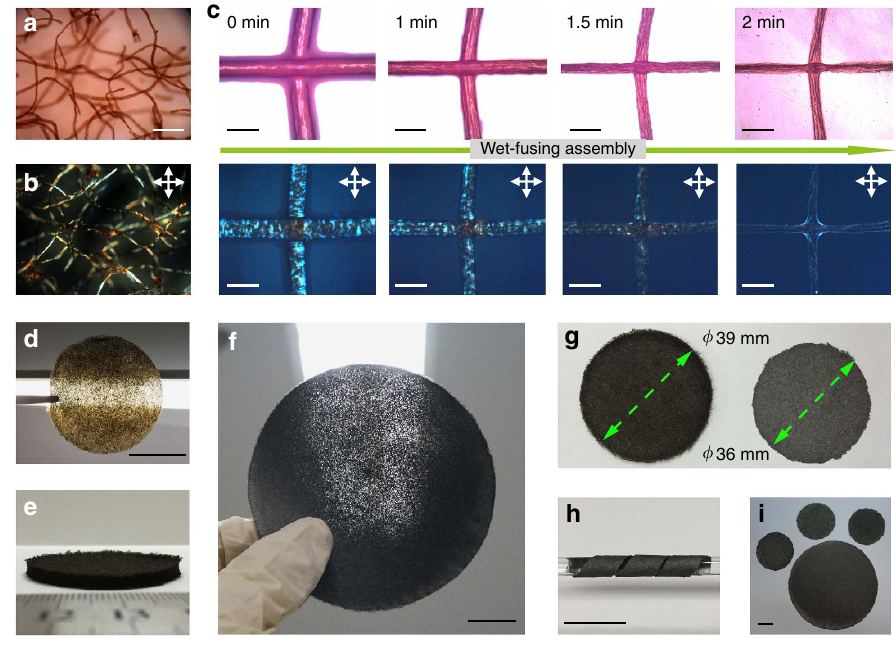
Figure 2 | Mechanism of wet-fusing assembly and morphology of the as-prepared GOFFs and GFFs. Micrographs of the re-dispersed GO fibres in a H 2 O/ethanol mixture under ( a ) OM and ( b ) polarized-light optical microscopy (POM). ( c ) Wet-fusing of GO fibres recorded under OM and POM. Photographs of ( d ) a piece of thin GOFF (thickness 0.05mm) held towards an light-emitting diode lamp, showing its porous structure and light brown colour, ( e ) a thick and dark brown GOFF (thickness 3mm), ( f ) a thermally annealed GFF with porous feature for light and gas penetration, ( g ) GOFF (left) and GFF (right), indicating the slight shrinkage of lateral dimension and colour change, ( h ) a strip of GFF coiled around a glass rod and ( i ) four GFFs of different sizes and thicknesses. Scale bars, 500 m m ( a , b ), 150 m m ( c ) and 20mm ( d , f , h , i ). NATURE COMMUNICATIONS|7:13684|DOI: